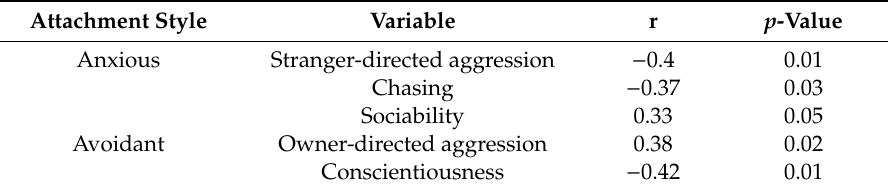
Table 3. Significant correlations between attachment style, dog and owner personality traits and dog aggressive owner-reported behavior.